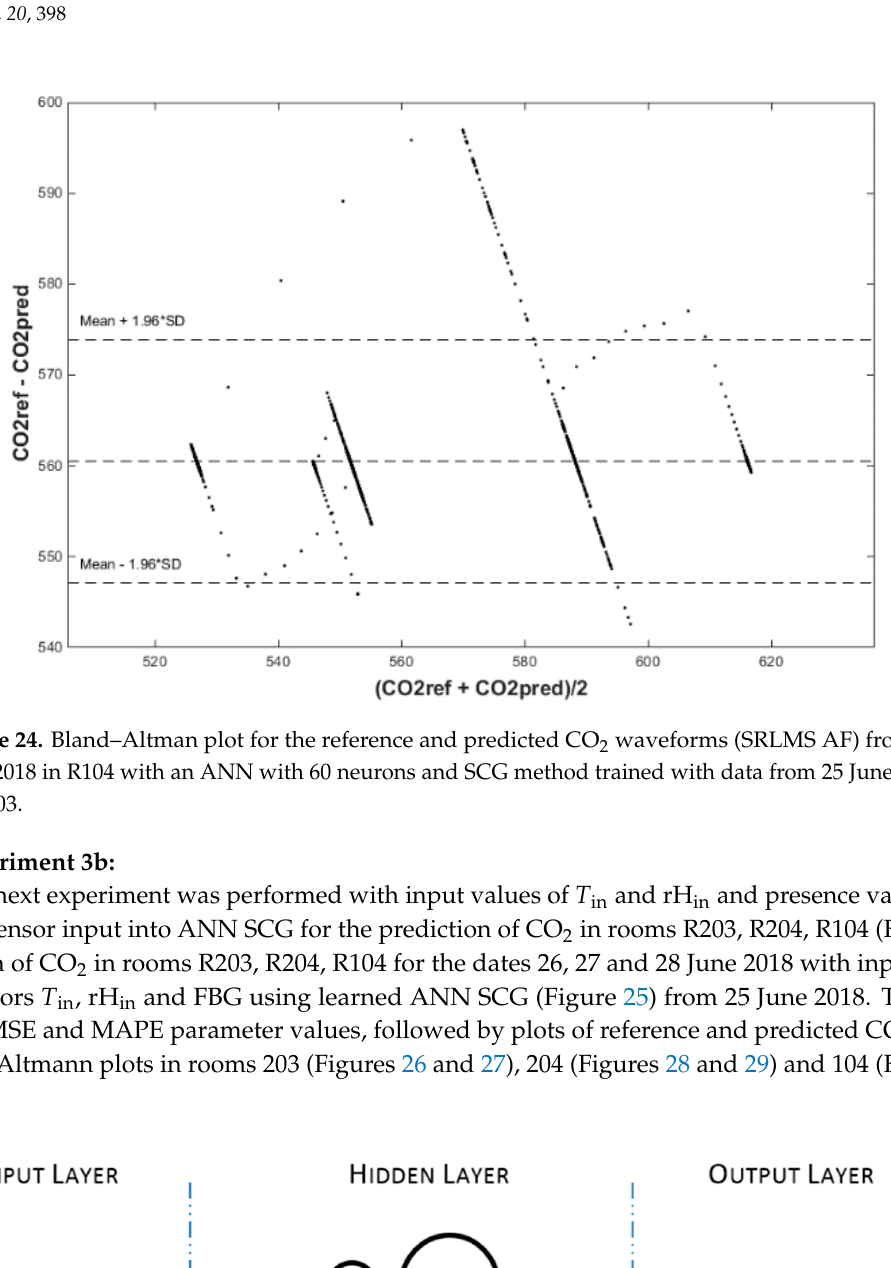
Figure 23. Comparison of the reference and predicted CO 2 waveforms (SRLMS AF) from 28 June 2018 in R104 with an ANN with 60 neurons and SCG method trained with data from 25 June 2018 in R203.